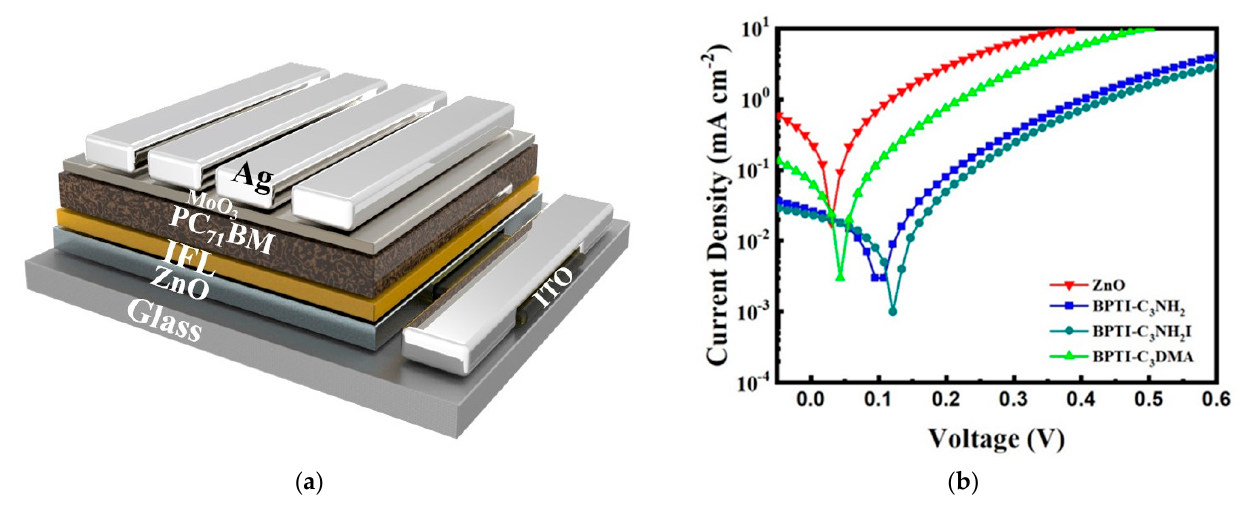
Figure 5. ( a ) MSM structure and ( b ) photoelectric flow curves of the devices.